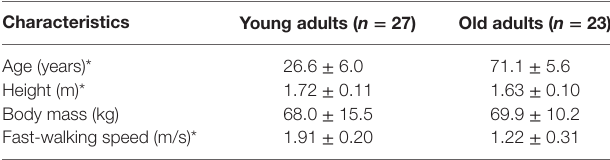
Table 1 | Characteristics of study’s participants.